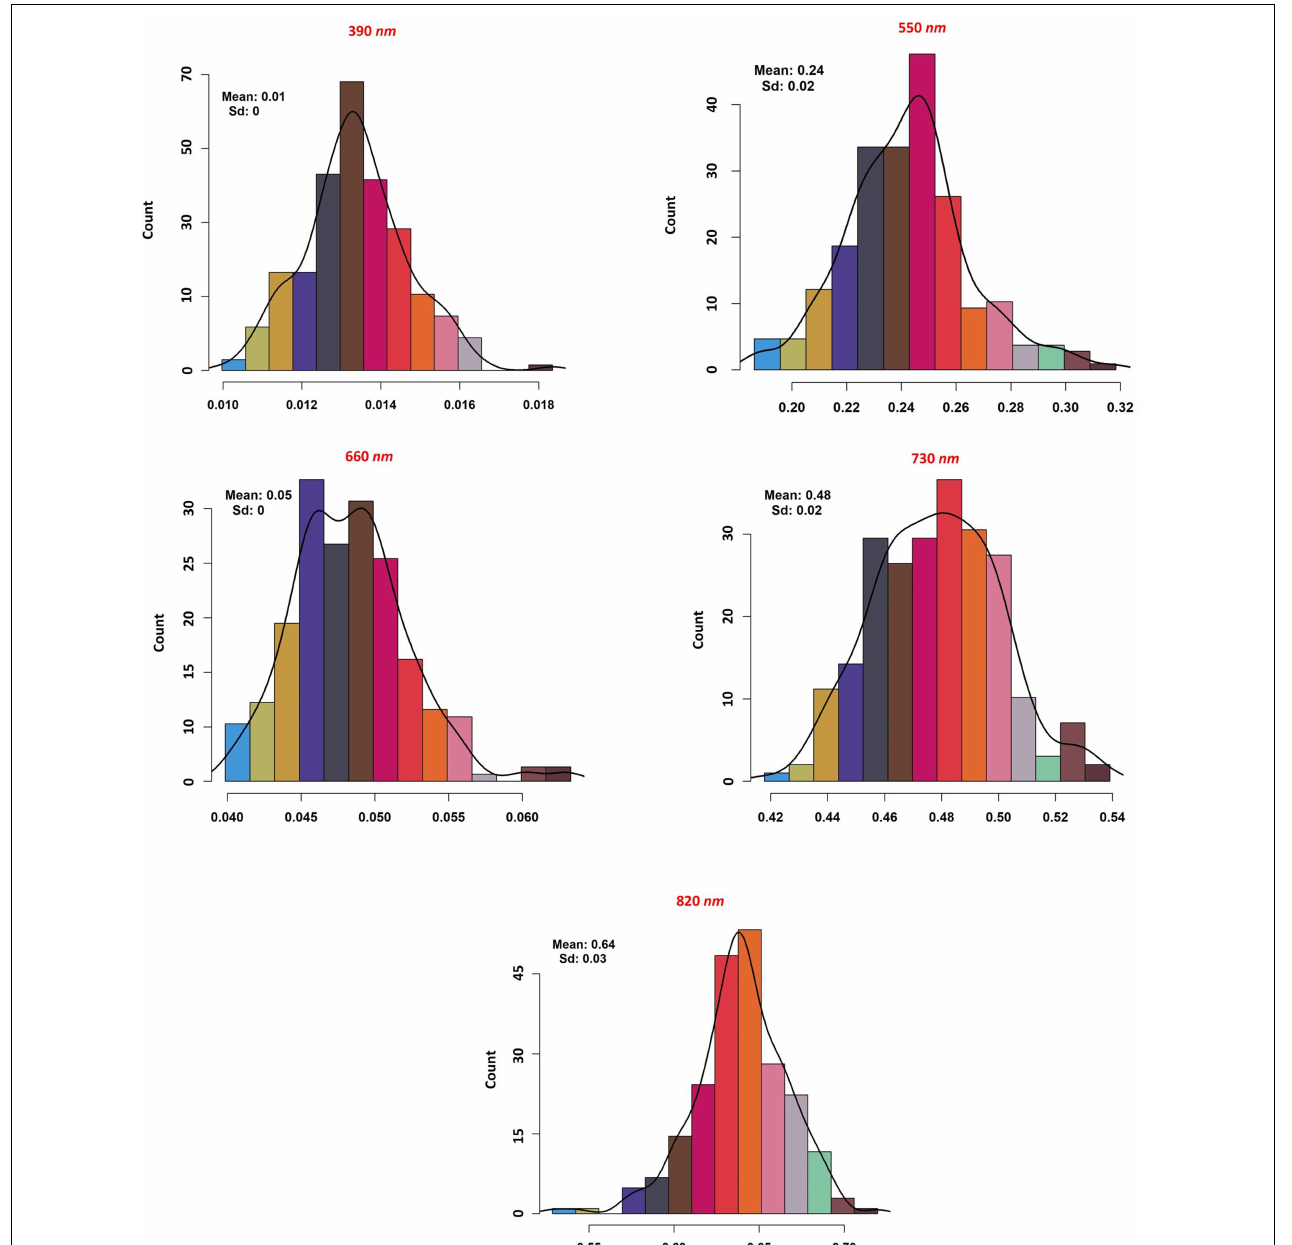
FIGURE 5 | The distribution, mean and standard deviation of the selected hyperspectral reflectance bands in the tested soybean